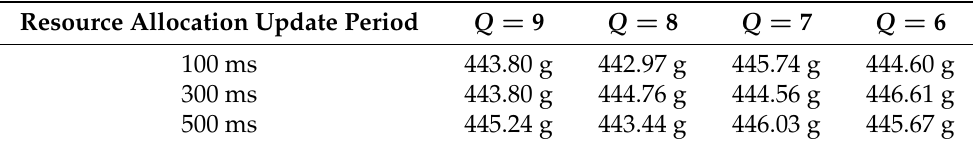
Table 3. The fuel consumption of vehicle platooning with different resource allocation periods and different numbers of reusable uplink